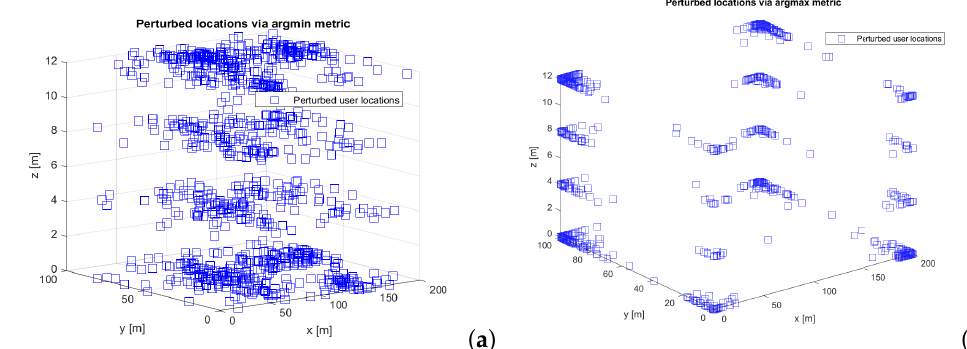
Figure 5. Examples of perturbed locations based on ( a ) M argmin ( · ) and ( b ) M argmax ( · ) metrics. (cid:101) = 0.1 m, Laplace perturbation.